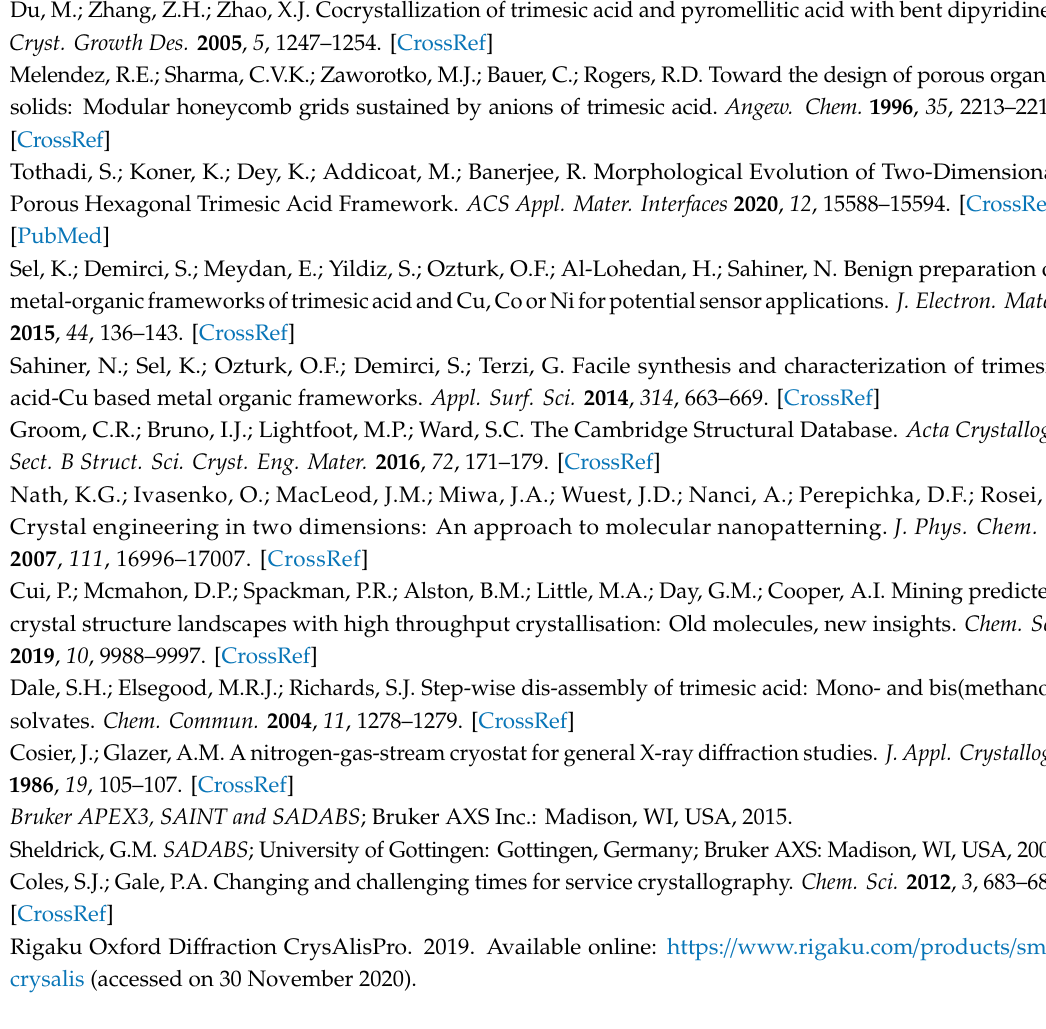
Figure S1: X-ray di ff raction pattern of solids from liquid-assisted grinding using various solvents. The DMSO and 1-pentanol patterns show di ff erent patterns to the α -TMA and are the known solvates. Figure S2: X-ray di ff raction pattern of solids slurry of TMA in various solvents. There are a few samples that indicate the potential for new solids in 2-butanone, acetonitrile and toluene. Figure S3: The evolution of the TMA:IPA crystal colour as a function of temperature. The phase transition from the ambient temperature form to the low temperature form occurs between 233 K and 243 K. Table S1: Experimental details for the TMA Ethanol solvate. Table S2: Experimental details for the TMA IPA solvate with variable temperature. Table S3: Experimental details for the TMA dimethylformamide